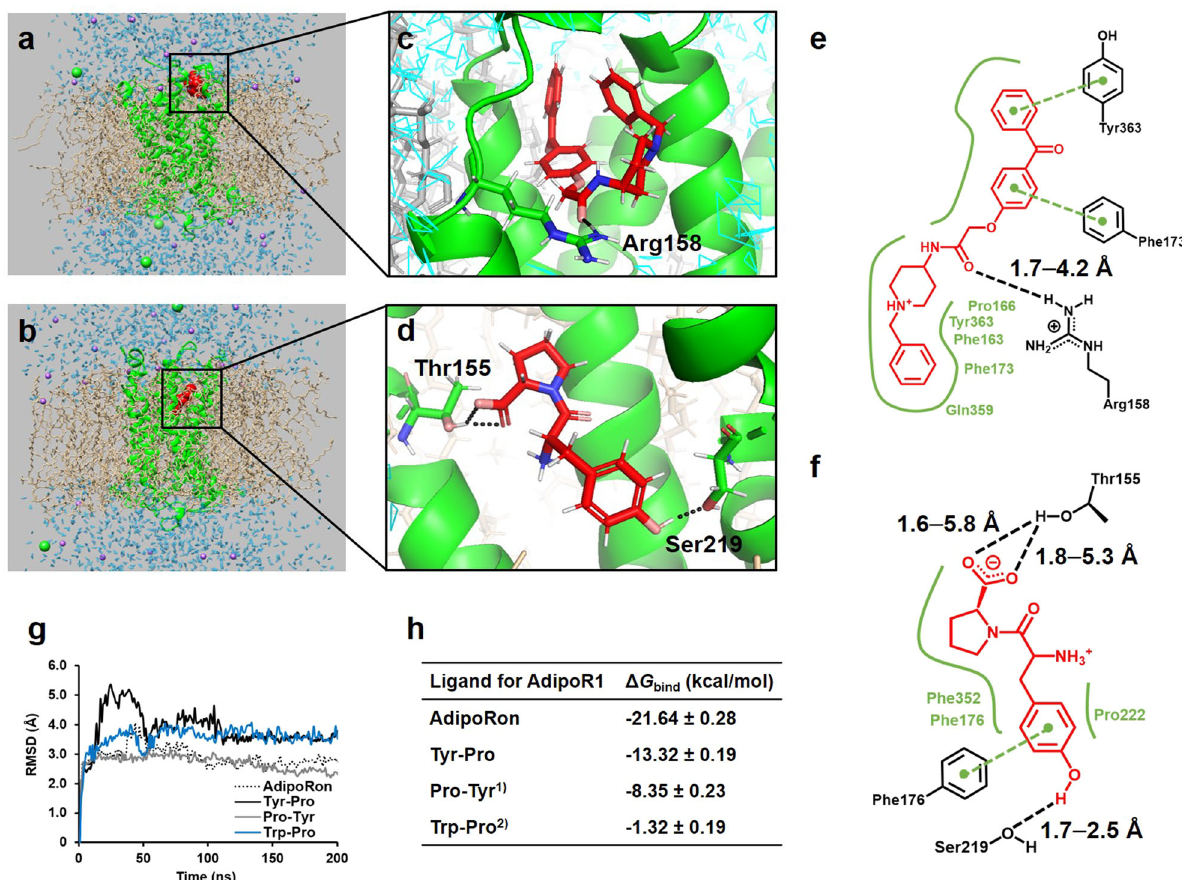
Fig. 6 In silico analyses at site 2. MD simulation analyses of CHARMM-GUI-guided ( a ) AdipoRon – AdipoR1 – POPC complex and ( b ) Tyr- Pro – AdipoR1 – POPC complex at site 2 of AdipoR1, visualized using UCSF Chimera ver. 1.14. The zoomed view snapshot at 200 ns using PyMOL displays the binding conformations of ( c ) AdipoRon and ( d ) Tyr-Pro complexes. The corresponding colors are as follows: C atom, red; H atom, white; N atom, blue; O atom, pink. Intermolecular interactions of ( e ) AdipoRon and ( f ) Tyr-Pro complexes at 200 ns were visualized using Protein Plus . Binding conformations are as follows: hydrogen bond, black dashed line; hydrophobic interaction, green straight line; π – π electron interaction, green dashed line. g A protein backbone root-mean-square deviation (RMSD) value from the initial structure of the ligand – AdipoR1 – POPC complex was computed for 200 ns. h The average binding free energy scores for 180 – 200 ns, Δ G bind (kcal/mol) of AdipoRon – AdipoR1, Tyr-Pro – AdipoR1, Pro-Tyr – AdipoR1, and Trp-Pro – AdipoR1 complexes in POPC. 1) The MD simulation analyses for Pro-Tyr at site 2 can be seen in Fig. S7 and Movie S7. 2) The MD simulation analyses for Trp-Pro at site 2 can be seen in Fig. S7 and Movie